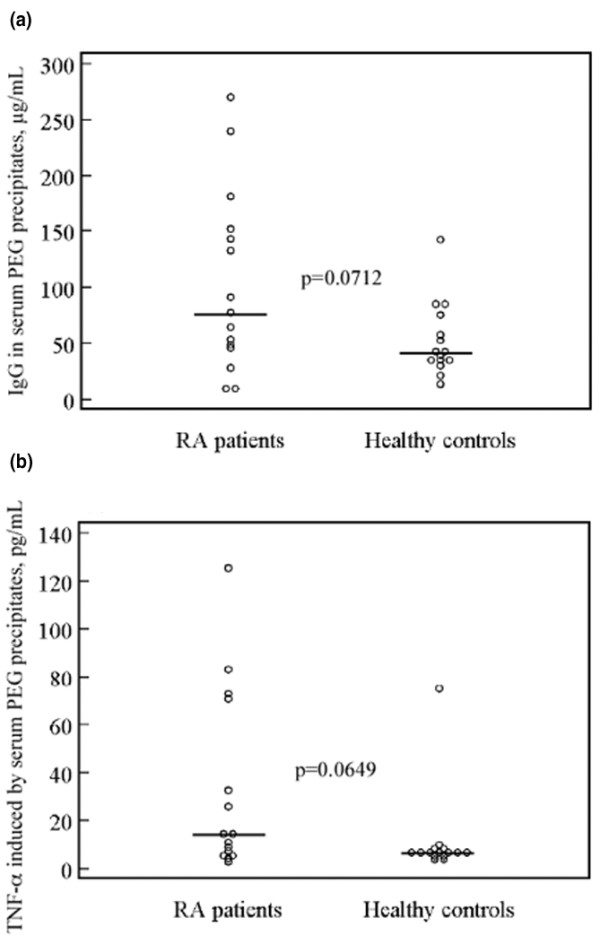
Trend for higher IC levels and IC-induced TNF-α levels in RA compared to control sera. Sera from 15 RA patients and 15 healthy control individuals were PEG precipitated and added to PBMC cultures and incubated for 20 hours at 37°C with 5% carbon dioxide, after which supernatants were harvested and TNF-α measured using ELISA. Nonsignificant trend toward (a) higher IgG levels and (b) greater TNF-α induction from RA precipitates as compared with healthy controls were apparent. Horizontal bars show the median value for each group. ELISA, enzyme-linked immunosorbent assay; PBMC, peripheral blood mononuclear cell; PEG, polyethylene glycol; RA, rheumatoid arthritis; TNF, tumour necrosis factor.